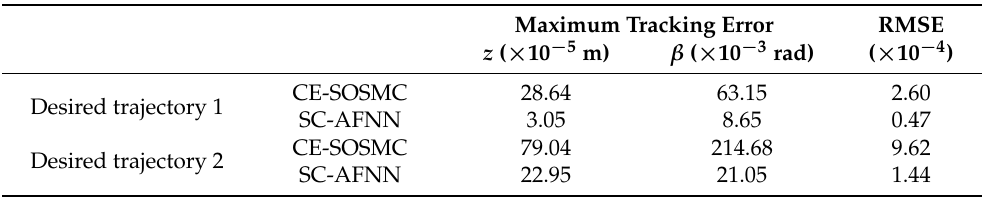
Figure 11. The experimental tracking error curves of the UBSHR’s end-effector (desired trajectory 2). ( a ) Experimental tracking error curves in z -direction (6 s); ( b ) Experimental tracking error curves of β (6 s). Table 3. The experimental numerical values of the steady-state performance and RMSE for tracking different desired